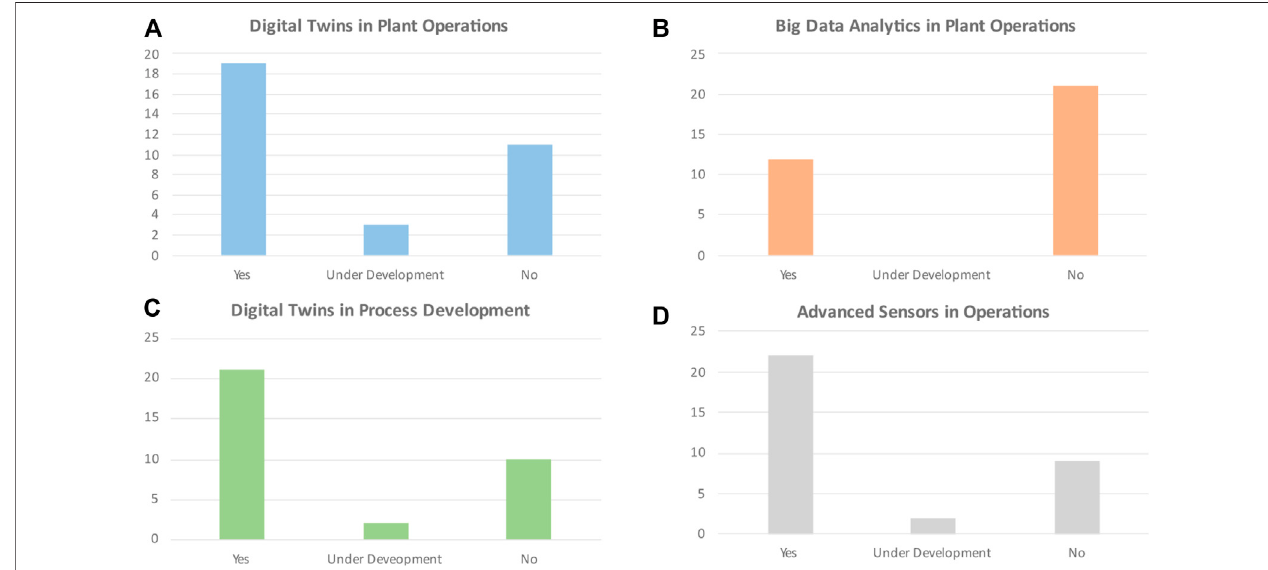
FIGURE 5 | The current state of digitalization technologies used in industry; (A) illustrates the use of Digital Twins during plant operations, (B) illustrates the use of Big Data analytics during plant operations, (C) illustrates the use of Digital Twins during process development, (D) illustrates the use of advanced sensors during plant